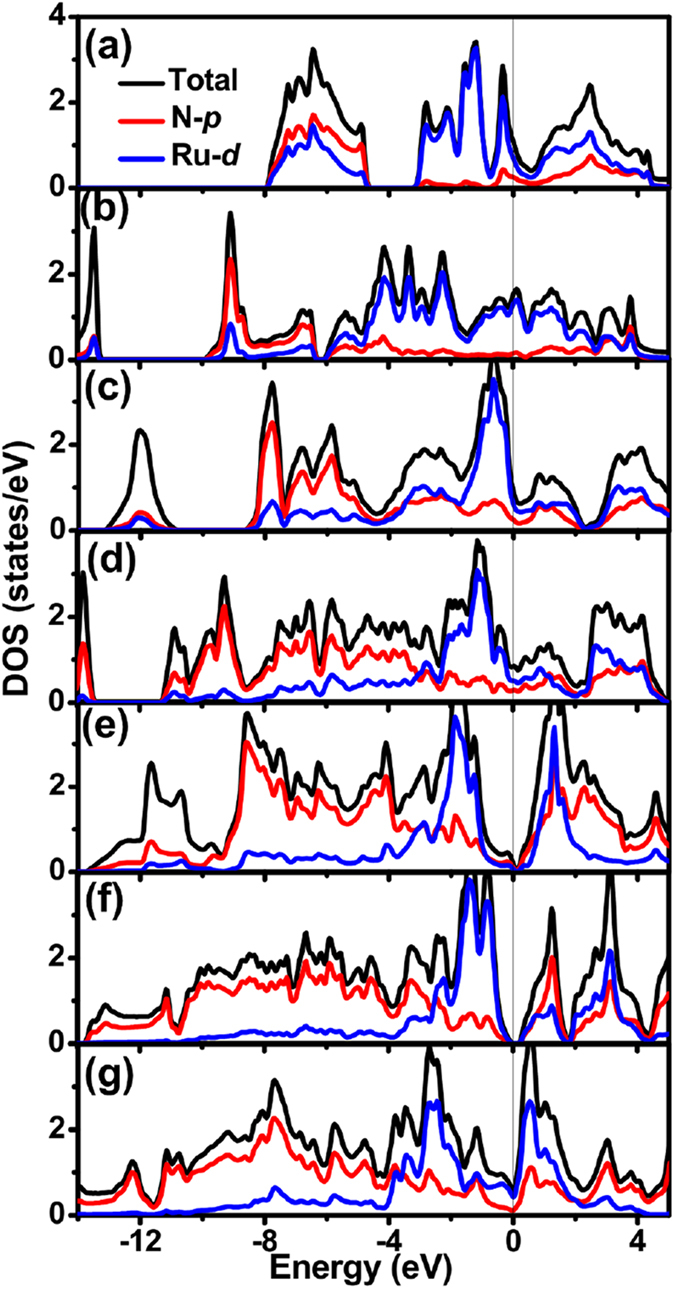
Calculated total and partial density of states for Ru nitrides.(a) I-4m2-RuN; (b) R-3m-RuN (c) Pnnm-RuN2; (d) P21/c-RuN3; (e) P4/mmm-RuN4; (f) C2/c-RuN4 and (g) Cmmm-RuN4. The vertical dash line at zero is the Fermi energy level.